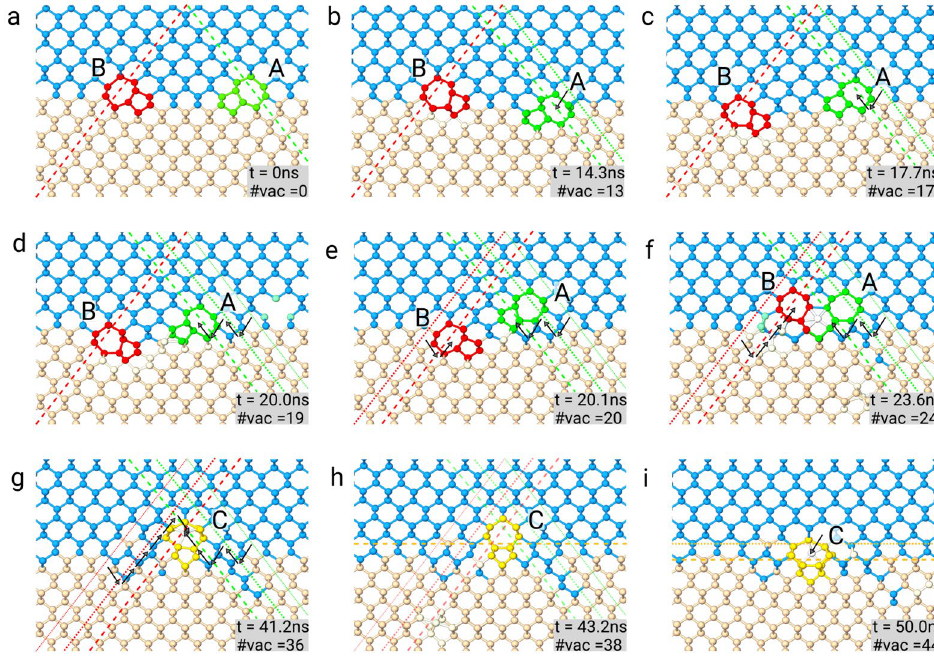
Figure 4. Simulation of a pair of 60 ◦ dislocations climb. Along all three rows, relevant snapshots of the evolution are shown. Light blue spheres represent Ge atoms, pink spheres Si atoms, green spheres highlight the core of the dislocation “A” (Burgers vector � b = a / 2 [ 011 ] ), red spheres highlight the core of the complementary dislocation “B” (Burgers vector � b = a / 2 [¯ 10 ¯ 1 ] ). The glide planes of the dislocations are shown by dashed lines colored accordingly to which dislocation they belong. Simulation snapshots are provided in sequence ( a – i ), the number of vacancies inserted in the cell and the corresponding simulation time are shown in the inset. Black arrows show the displacement of the